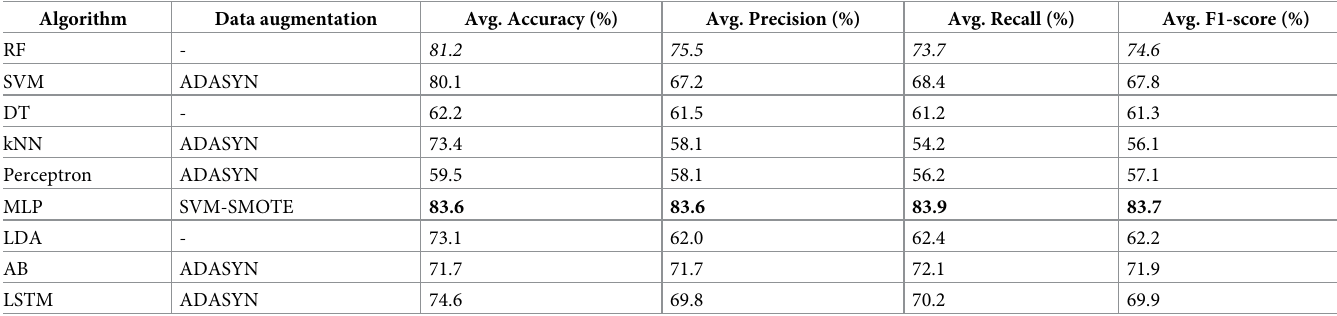
Table 8. Results of the trained models on the abstracted questionnaire.